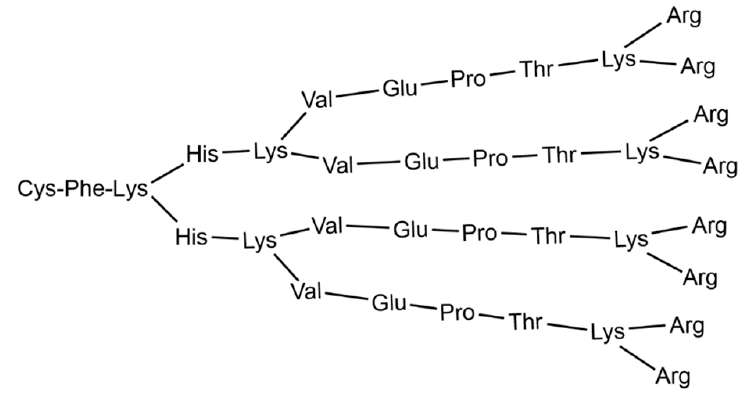
Figure 3. Structure of the cationic peptide dendrimer KK-46, usable as carrier of siCoV [133]. This compound, developed by the Institute of Immunology of the Federal Medical and Biological Agency of Russia, in collaboration with the St. Petersburg Research Institute of Vaccines and Serums, is used as a carrier of siRNA, modified to suppress SARS-CoV-2 (siCoV) by inhibiting its replication [134]. The association of KK-46 with siCoV has been named MIR 19 ® [135]. Based on preclinical data, the researchers hypothesized that SARS- CoV-2 inhibition by siCoV/KK46 could potentially reduce lung inflammation, thereby improving treatment outcomes. According to the test results, the drug was registered and introduced into civil circulation by the Ministry of Health of the Russian Federation on